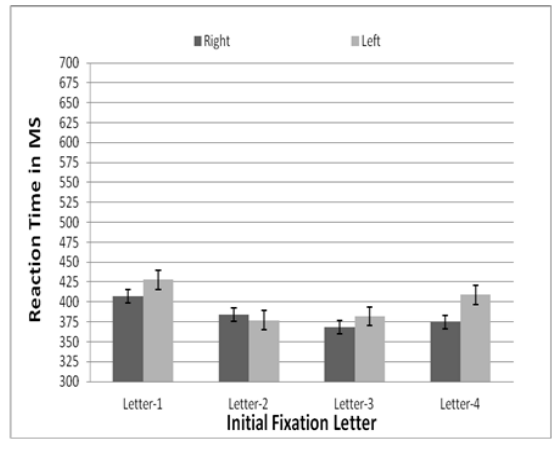
Figure 4. The reaction time of four-letter words as a function of the position of unconnected word sub- units (right, left) and initial fixation letter (first, second, third, and fourth). Note: Error bars represent standard